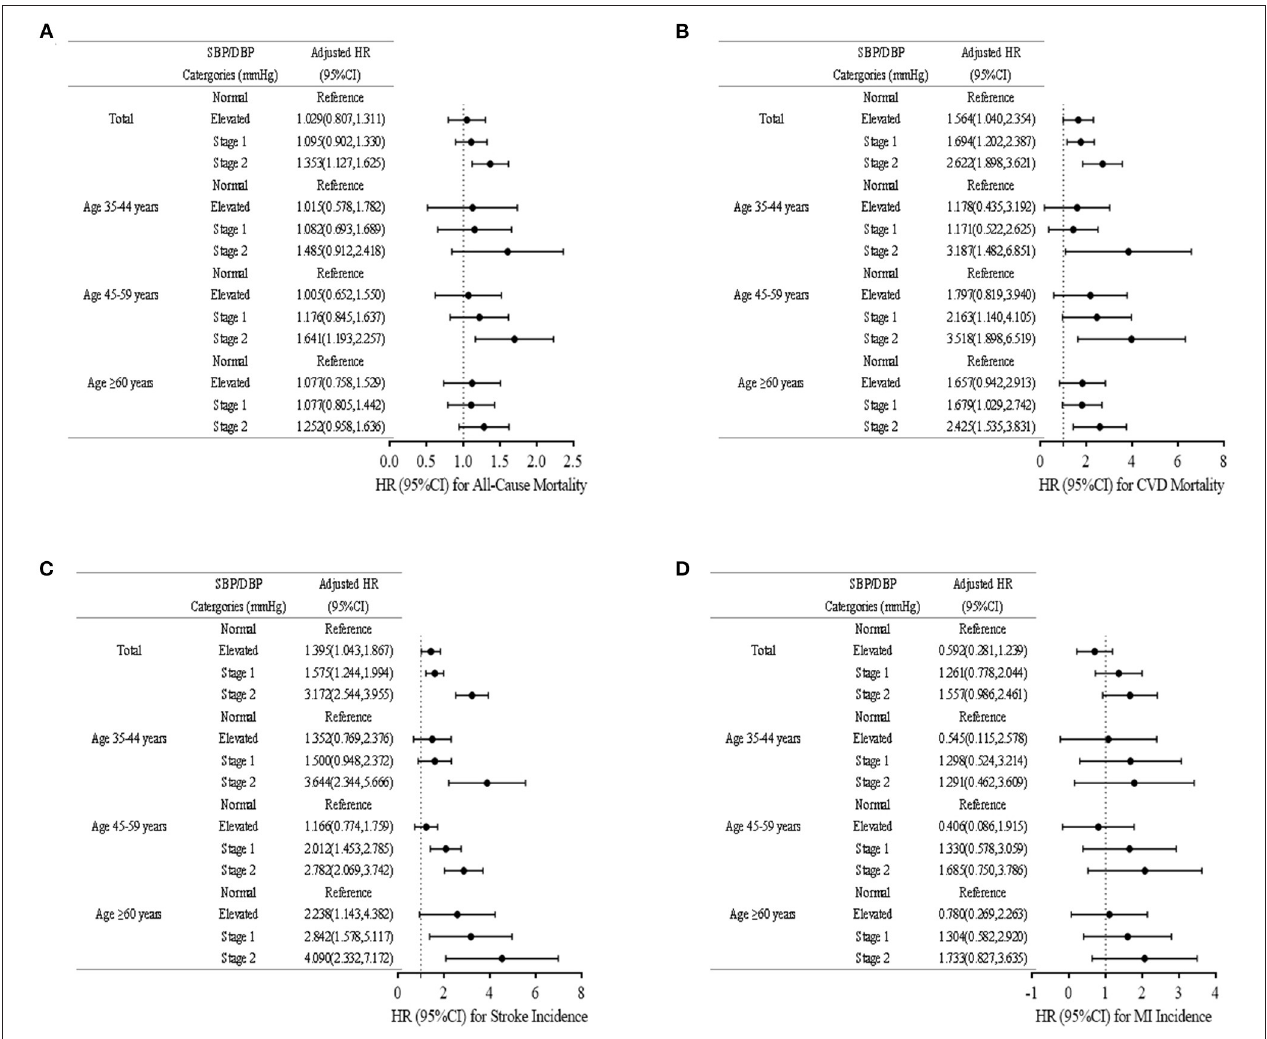
FIGURE 3 | Cox regression analyses for association. Incident (A) All-Cause Mortality, (B) Cardiovascular Disease Mortality, (C) Stroke Incidence, and (D) Myocardial Infarction. Error bars represent 95% CI. Normal: SBP < 120mm Hg and DBP < 80mm Hg; Elevated: SBP of 120–129mm Hg and DBP of < 80 mmHg; Stage 1: SBP of 130–139 mmHg or DBP 80–89 mmHg; Stage 2: SBP/DBP ≥ 140/90mm Hg, or taking antihypertensive medications. SBP, systolic blood pressure; DBP, diastolic blood pressure. CI, confidence interval. Adjusted for age, current smoking, current drinking, ethnicity, education level, physical activities, BMI, history of diabetes, family history of hypertension, history of